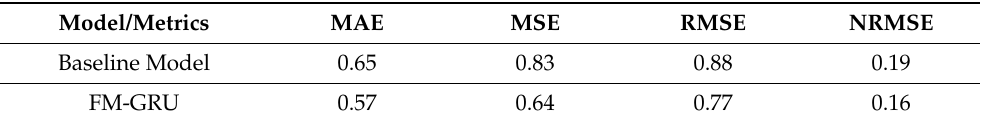
Table 3. Performance comparison of the Baseline Model and FM-GRU.